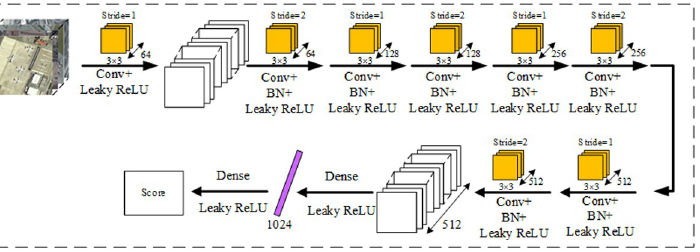
Fig 5. Our discriminant networks. We replace the last layer of the Sigmoid function with Leaky ReLU, and the rest is consistent with the original network.